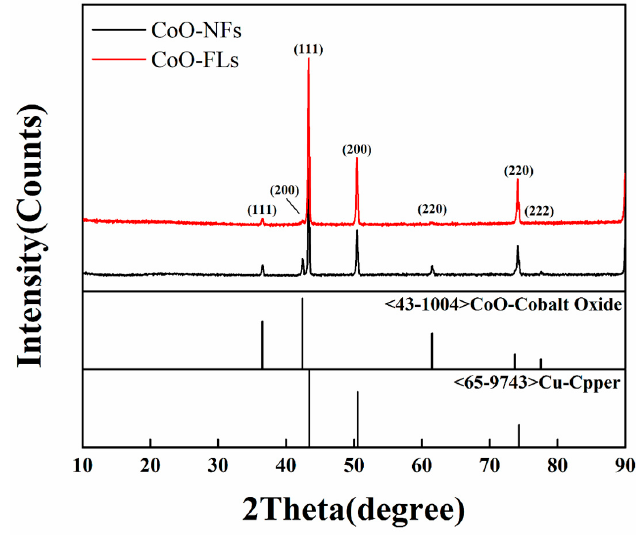
Figure 1. XRD patterns of CoO-NFs and CoO-FLs.